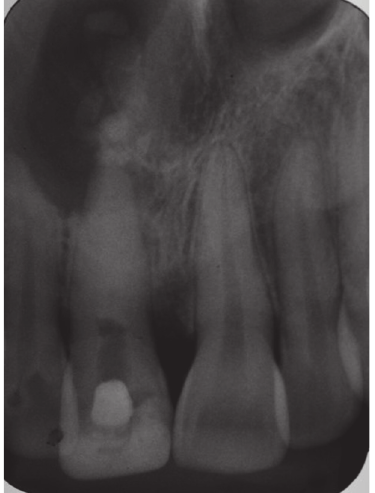
Figure 3: Postsurgical